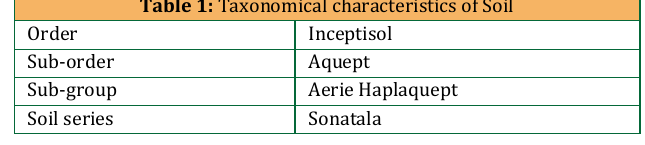
Table 2: Morphological characteristics of Soil Morphology